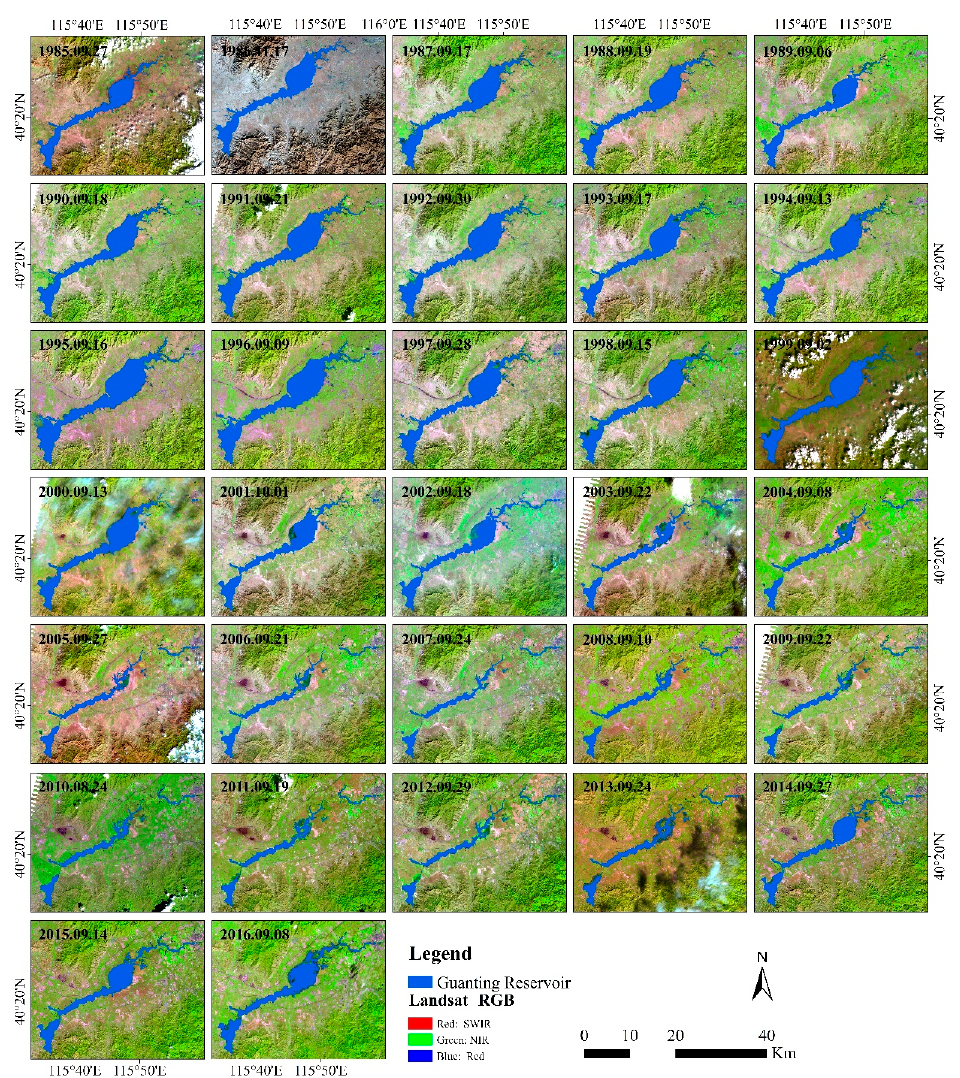
Figure A1. Acquisition dates of Landsat-series images.